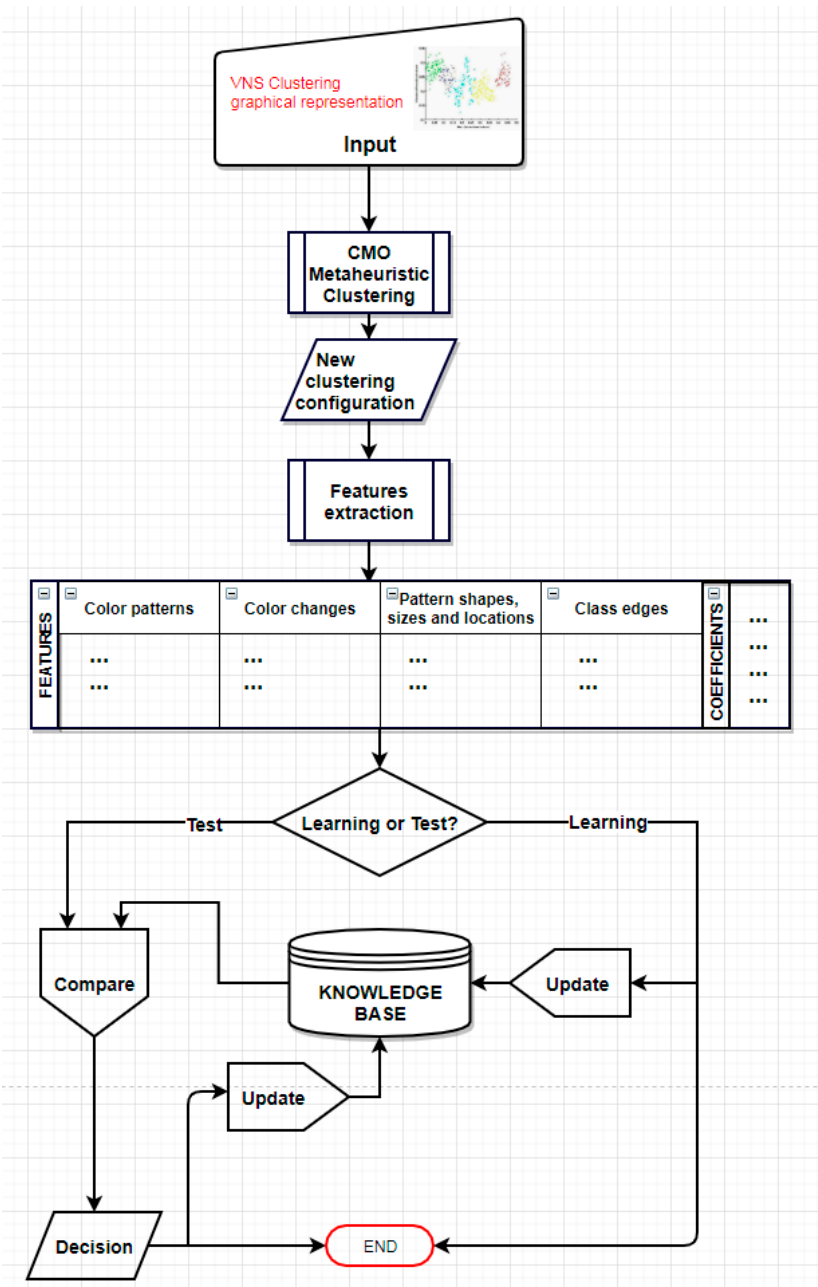
Figure 7. Workflow of the detection phase.